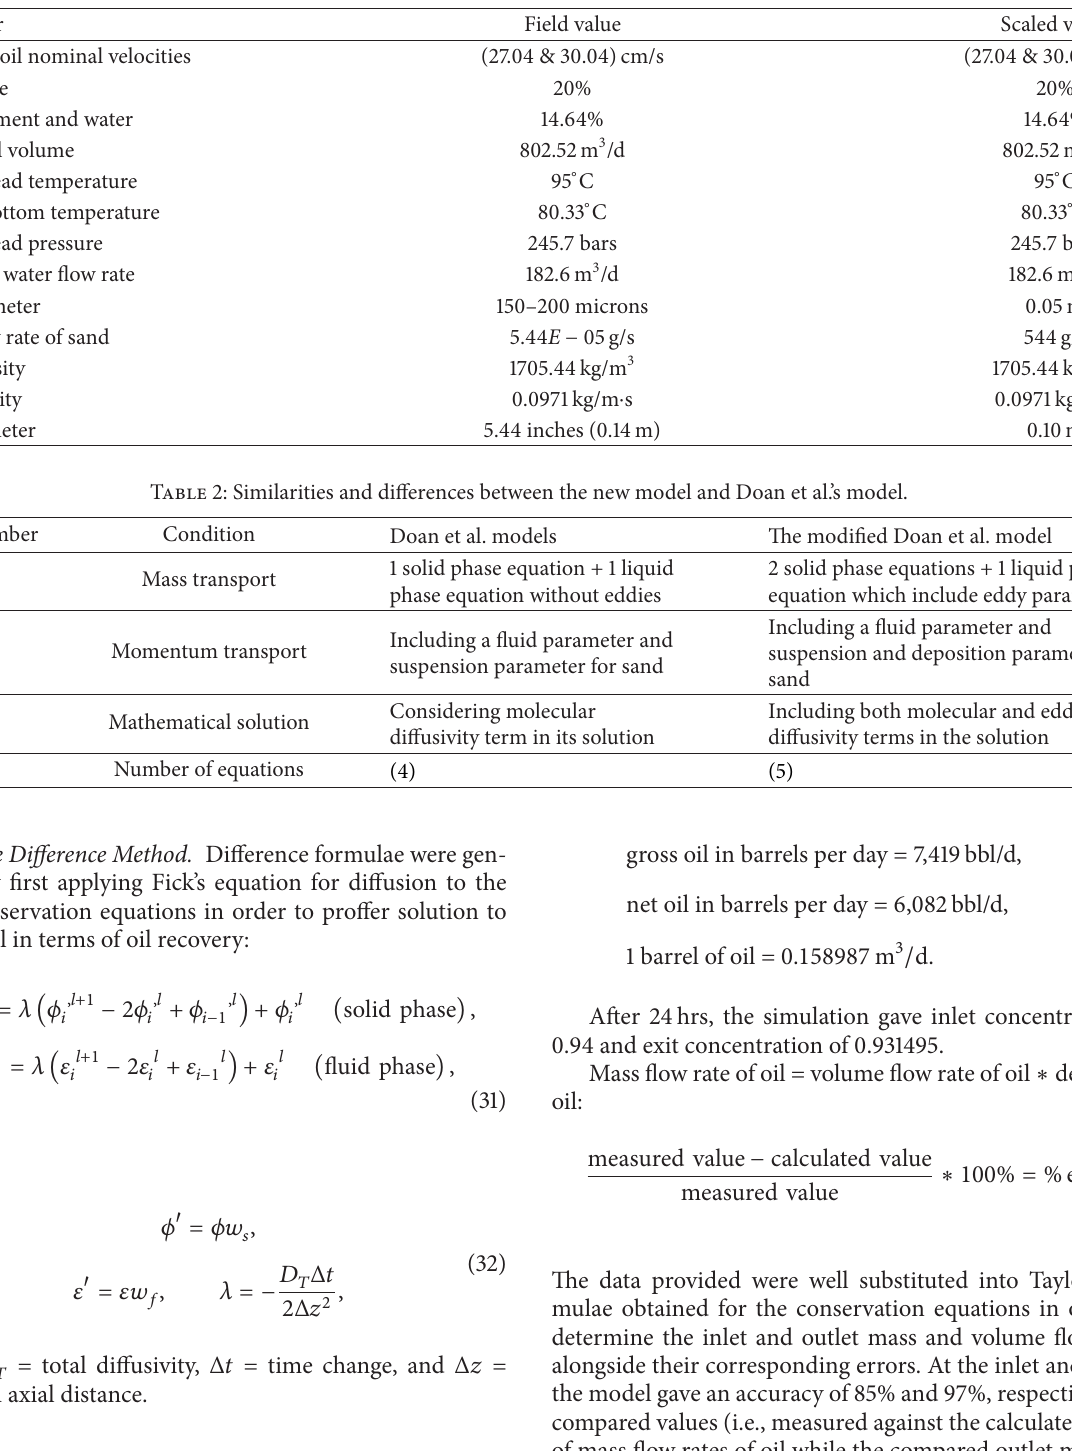
Table 1: Values and variables used in the model.